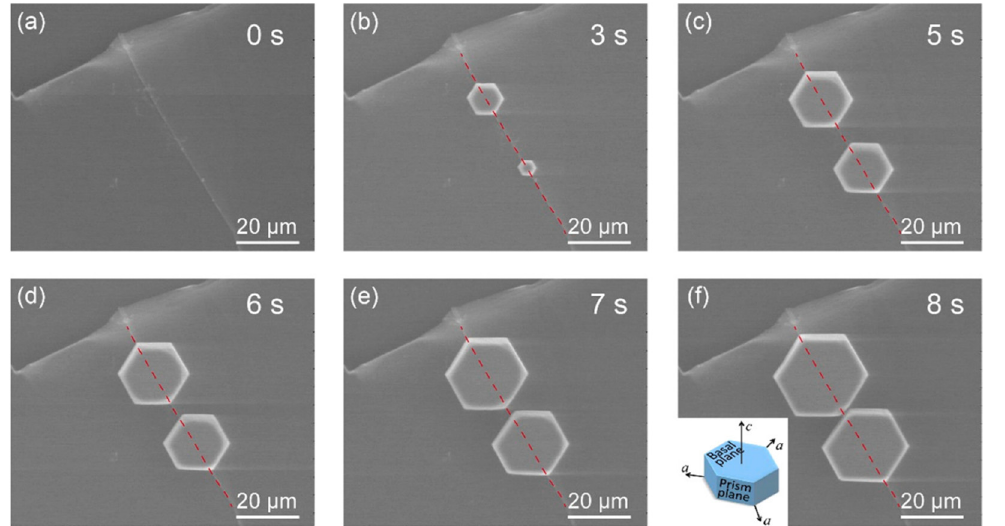
Figure 7. In situ ESEM image series for the atomic-step-induced aligned growth of hexagonal ice crystals on the HOPG surface at − 14 °C. ( a ) Morphology of the atomic step on the HOPG surface. ( b – f ) Nucleation and growth dynamics of hexagonal crystals in the step area, with their (0001) basal plane parallel to the HOPG surface. The crystals were further aligned by the atomic step, as one of their a-axes coincides with the step edge during their growth. The inset in ( f ) shows the basic lattice unit of the hexagonal ice crystal with two basal planes (0001) and six equivalent prism planes (1010). The crystal has three identical a-axes. The red dotted line in each image indicates the edge position of the corresponding atomic step. Reprinted with permission from [77]. Copyright 2020 American Chemical Society.